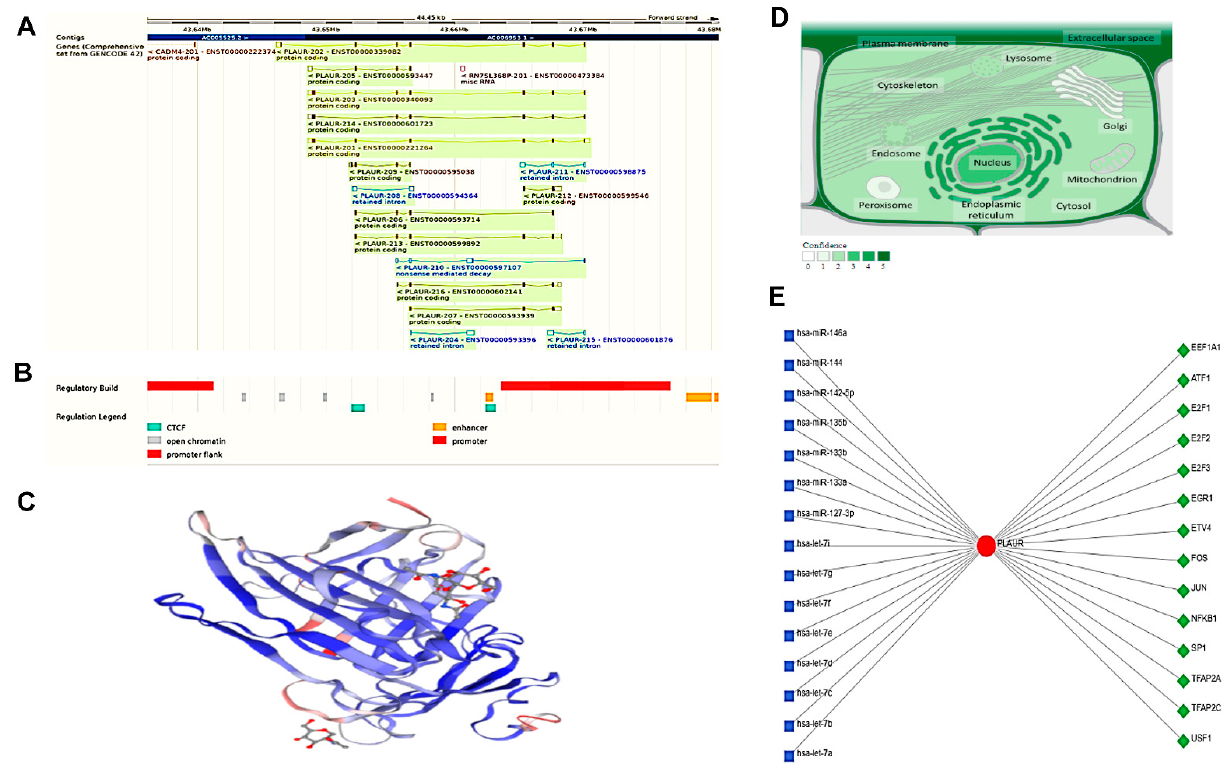
Figure 6. The plasminogen activator, urokinase receptor (PLAUR) structural and functional analysis. ( A ) The chromosomal location and the related transcripts. The blue color is non-coding, while the others are coding transcripts; ( B ) the sites of the promoter and enhancer regulatory factors, either Cis or trans; ( C ) the predicted 3D structure of the PLAUR generated through SWISS modelling; ( D ) the localization of the PLAUR. The color degree is related to protein abundance subcellular, and ( E ) the transcriptional factor (TF)-miRNA coregulatory interactions include 14 TF (green diamonds) interacting with the speci fi ed protein and 15 microRNAs (blue squares).